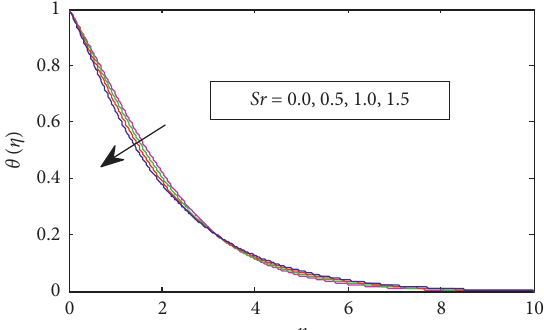
Figure 8: Temperature distribution for different values of Soret parameter.